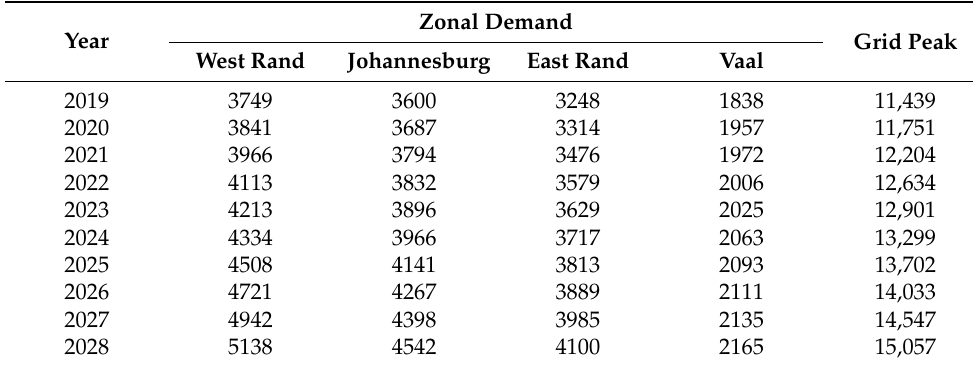
Figure 2. South African provincial load demand [30]. Table 1. Load progression in the Central grid.